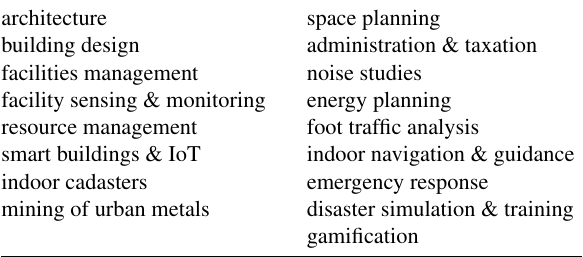
Table 1. Potential uses for indoor maps 3